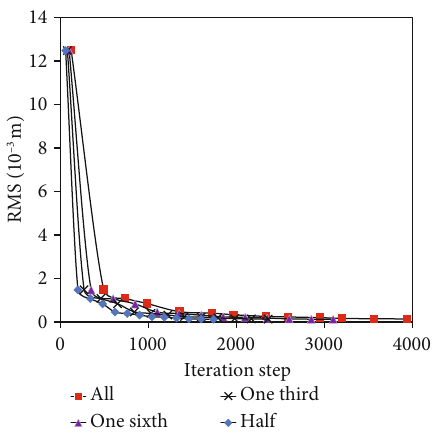
Figure 9: Iteration process of RMS error of the front cable net (quasi-Newton